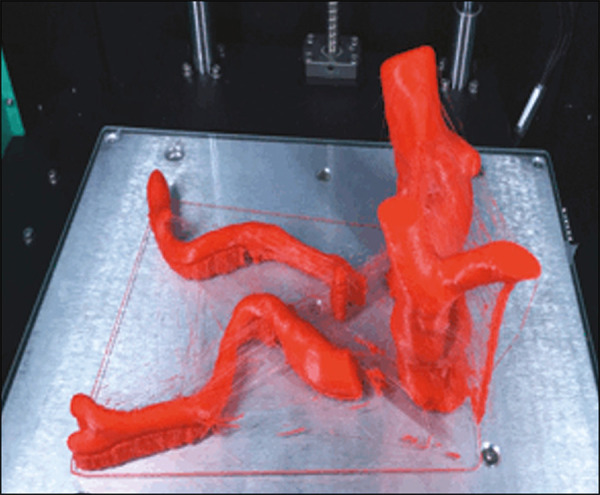
End of the process of printing the biomodel.